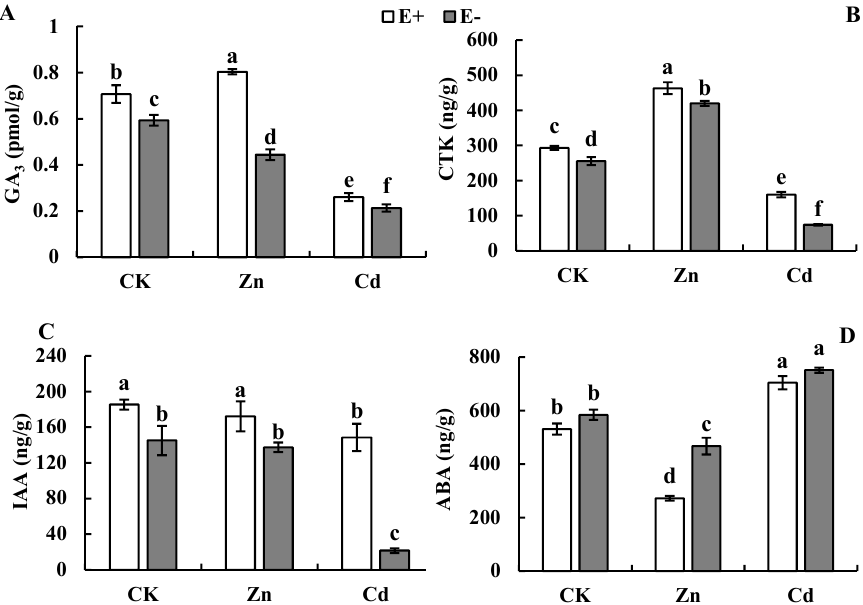
Figure 6. Effect of Epichloë endophytes and Cd 2+ and Zn 2+ treatments on the concentration of GA 3 ( A ), CTK ( B ), IAA ( C ) and ABA ( D ) in F. sinensis . Note: Different lowercase letters indicate significant differences between treatments ( p < 0.05).